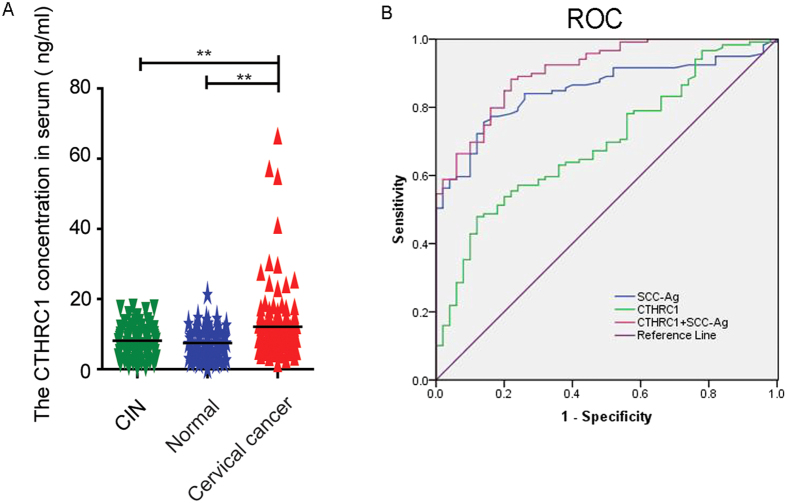
CTHRC1 is highly expressed in the serum of cervical cancer patients.(A) Comparisons of CTHRC1 concentration in serum of Cervical intraepithelial neoplasia (CIN), Normal, cervical cancer patients. (B) ROC curves of CTHRC1, SCC-Ag and combined. The results shown are mean ± SD of relative firefly/Renilla ratio.